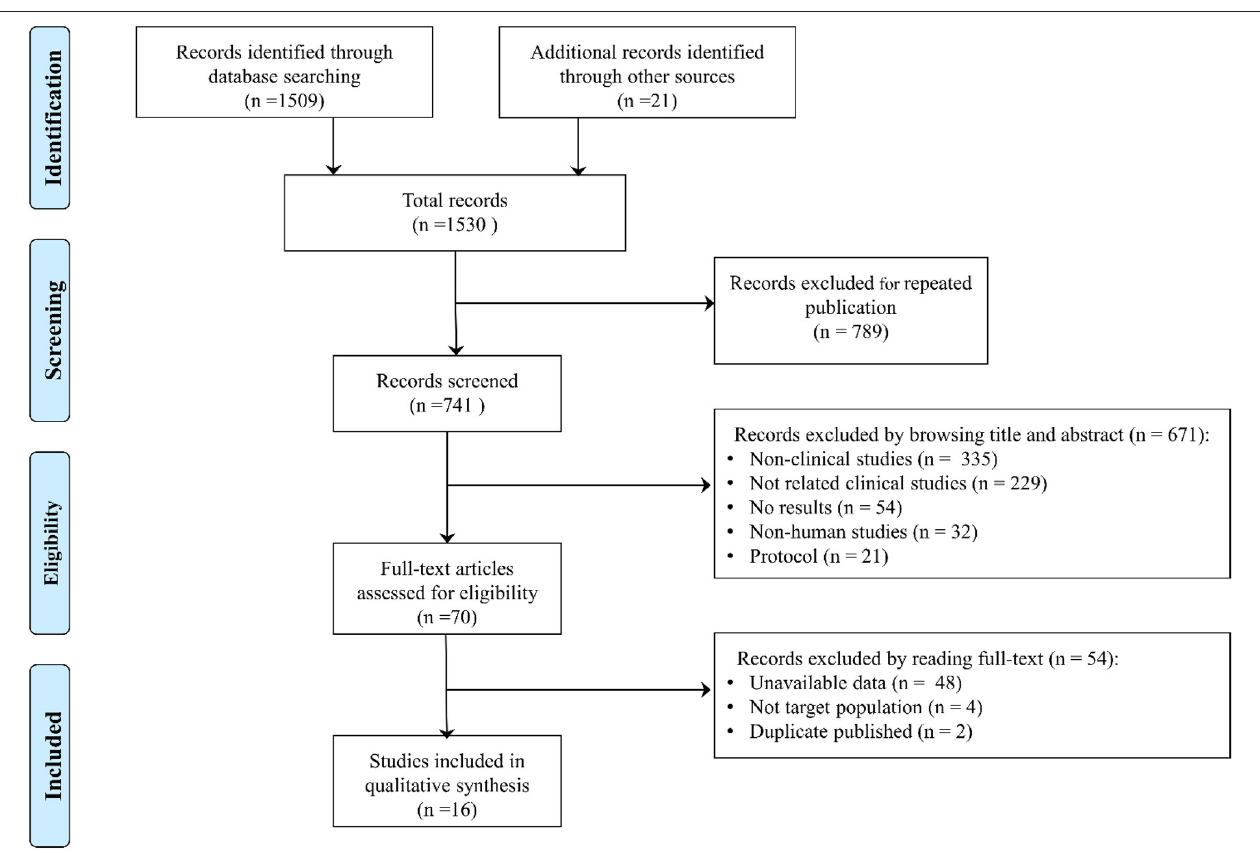
FIGURE 1 | PRISMA flow diagram of the literature search process.